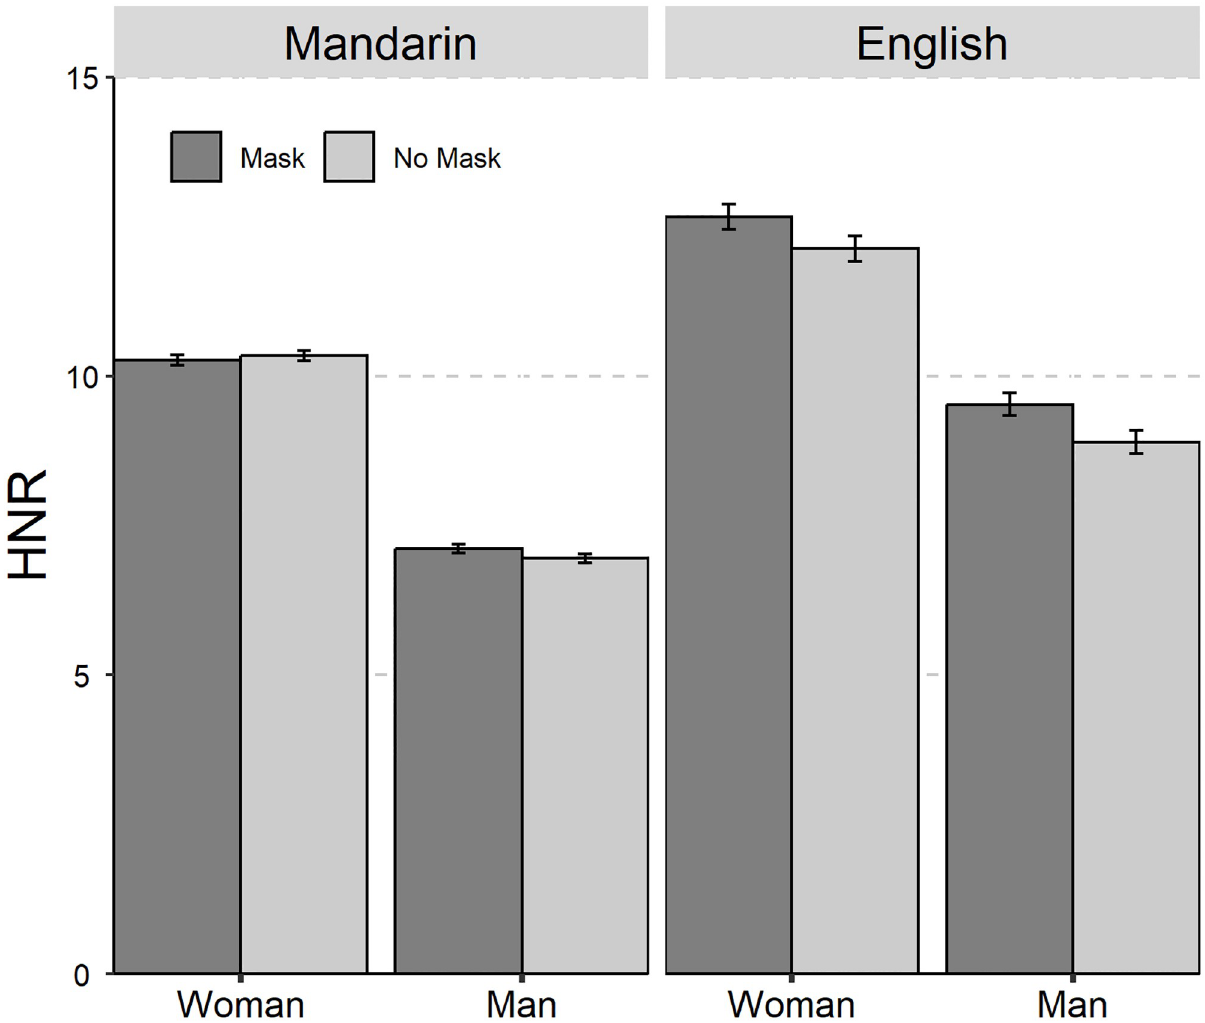
Fig 4. The bar plot (with standard error) of the harmonic-noise-ratio (HNR in dB) of Mandarin Chinese and English with and without mask across gender (female and male).